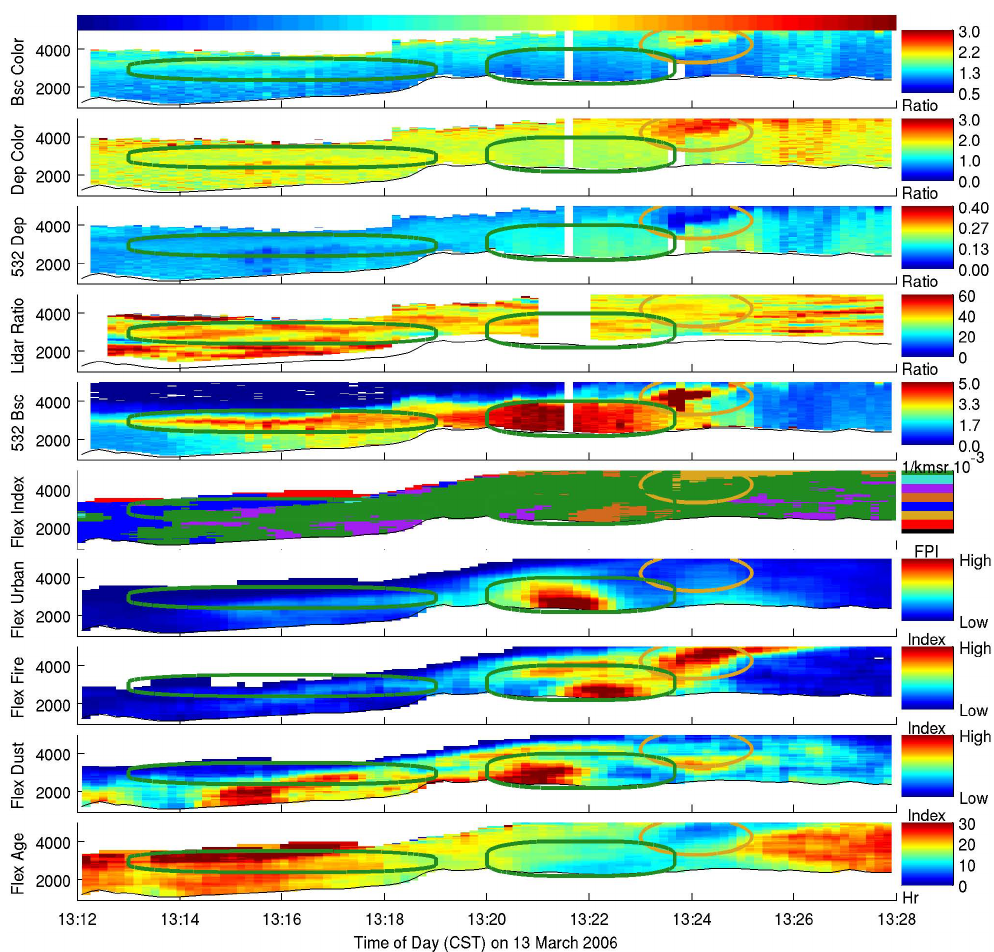
Fig. 11. Curtain plots of HSRL backscatter coefficients and intensive properties for northeastward flight through the mountain gap on 13 March 13:12 to 13:28, along with Flexpart average age and particle count index for dust, fire and urban emissions. See Fig. 12 for Flexpart Particle Index (FPI) legend. The yellow ellipse shows a biomass burning plume, and the green ellipses show mixed plume. The y-axis is height above mean sea level. The colorbar across the top corresponds to the trajectory shown in Fig.